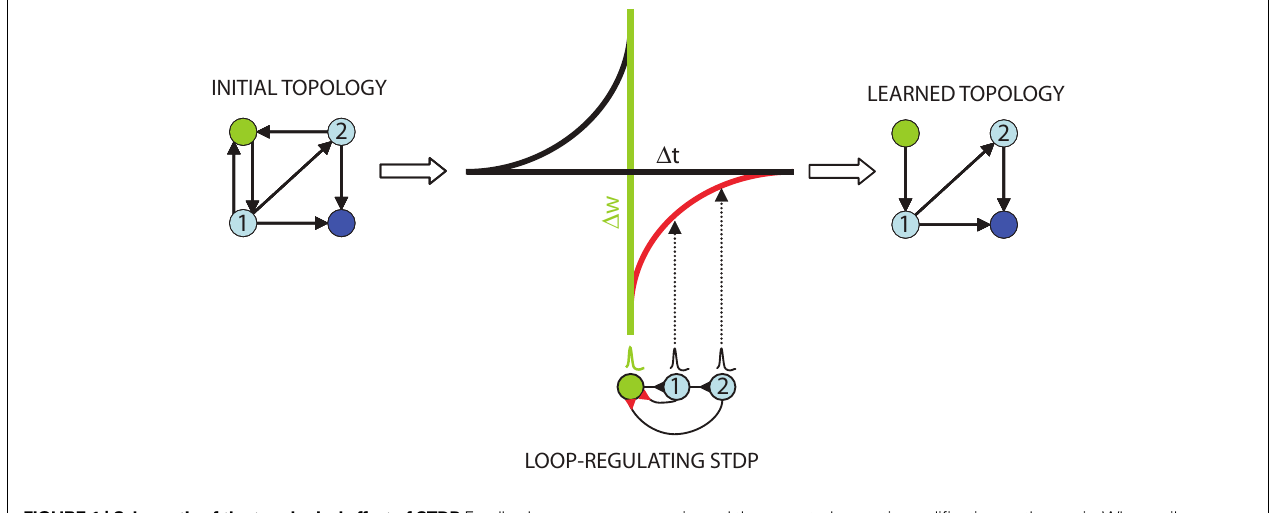
FIGURE 1 | Schematic of the topological effect of STDP. Feedback connections in an initial topology (left) from fi rst (1) and second (2) order “follower” neurons (light blue) to a “trigger” neuron (green) create loops of length k = 2 and k = 3. These connections are selectively penalized by the STDP learning rule (lower middle, red). The plot (middle) depicts this rule, with the time difference between follower (black) and trigger (green) action potentials on the